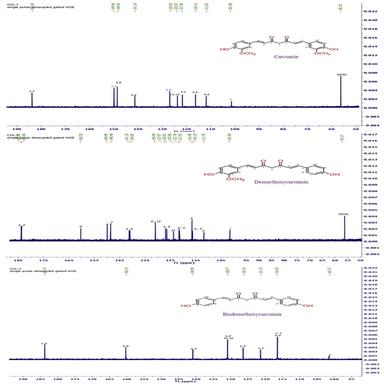
13CNMR spectrum of curcumin, desmethoxycurcumin, and bisdemethoxycurcumin.